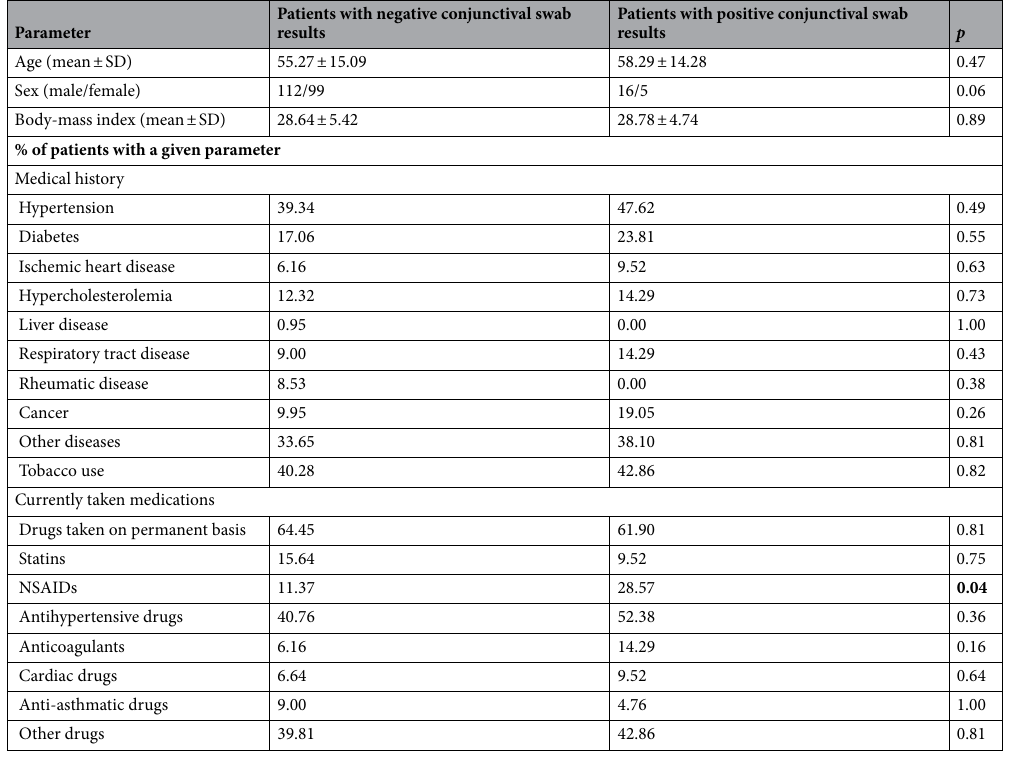
Table 1. General characteristics of patients with positive and negative conjunctival swab results. Statistically significant p values are shown in bold.